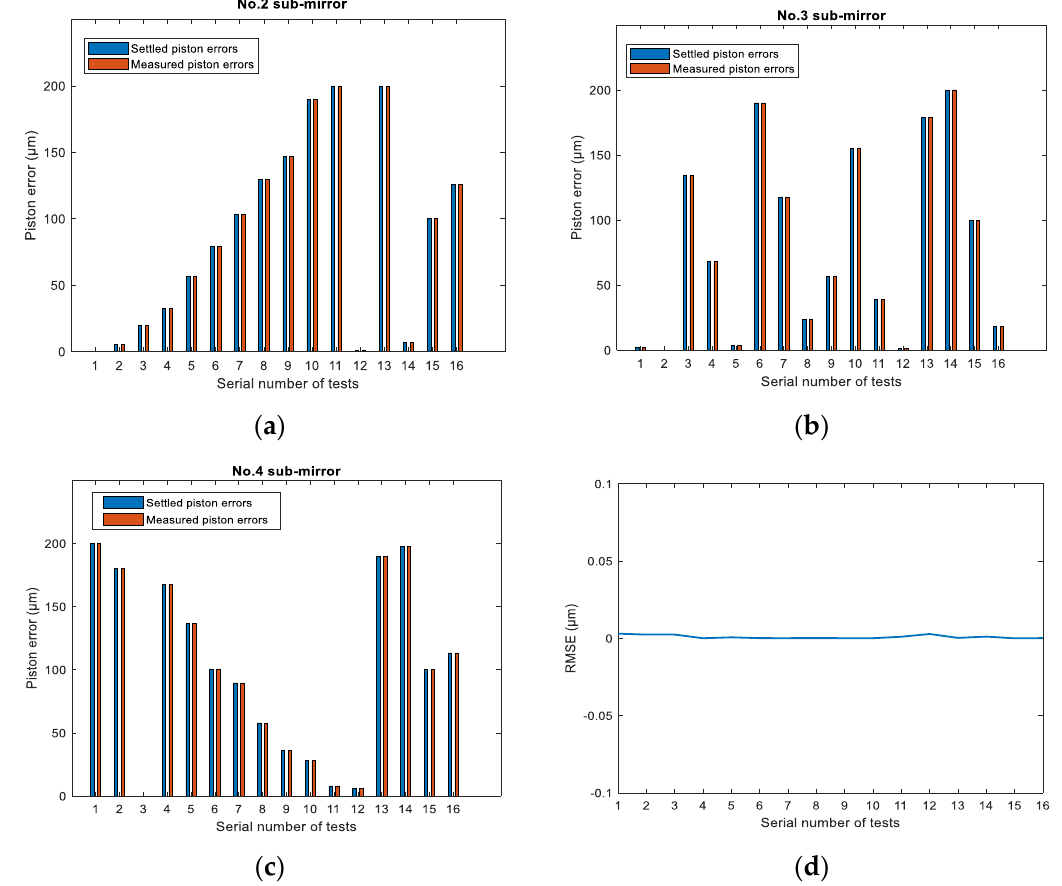
Figure 13. Piston error measurement results for the four-segment system: ( a – c ) piston error measurement results of No. 2, No. 3 and No.4 sub-mirrors, respectively, and ( d ) the total RMSE of the three sub-mirrors’ piston error measurement accuracy during each test.